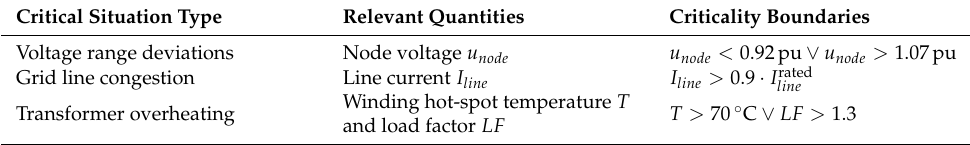
Table 2. Criticality boundaries that trigger counter measures. Adapted from ref.